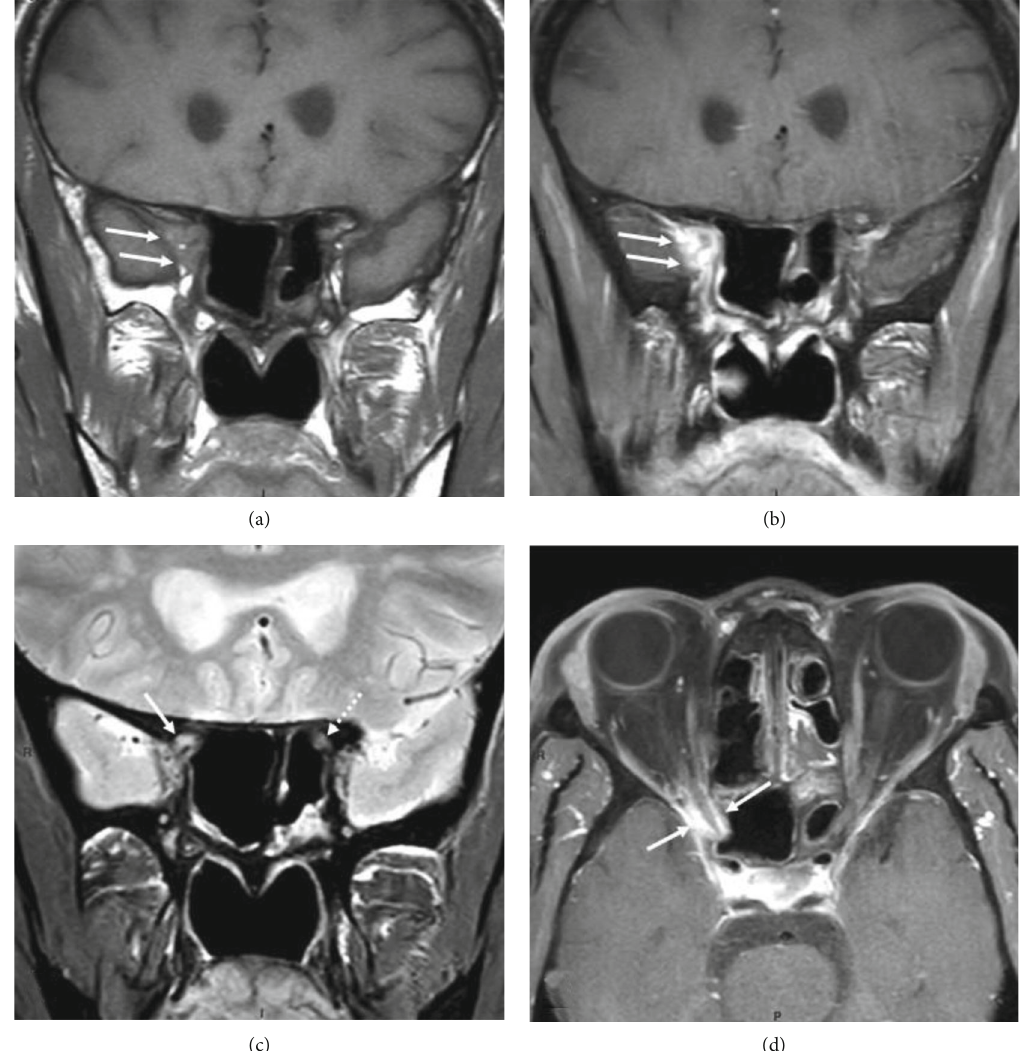
Figure 2: Orbital magnetic resonance imaging. (a) Coronal unenhanced T1-weighted view showing fi lling of the right sphenoid fi ssure by in fl ammatory material (double arrow). (b) Coronal contrast-enhanced T1-weighted view with fat suppression option in similar slice location as (a) showing intense enhancement of the in fl ammatory material (double arrow). (c) Coronal T2-weighted view showing abnormal hyper signal intensity of the intracanalar segment of the right optic nerve (arrow) when compared with normal contralateral side (dotted arrow). (d) Coronal contrast-enhanced T1-weighted view with fat suppression option showing a “ tramtrack ” -like encasement of the intracanalar segment of the right optic nerve (between